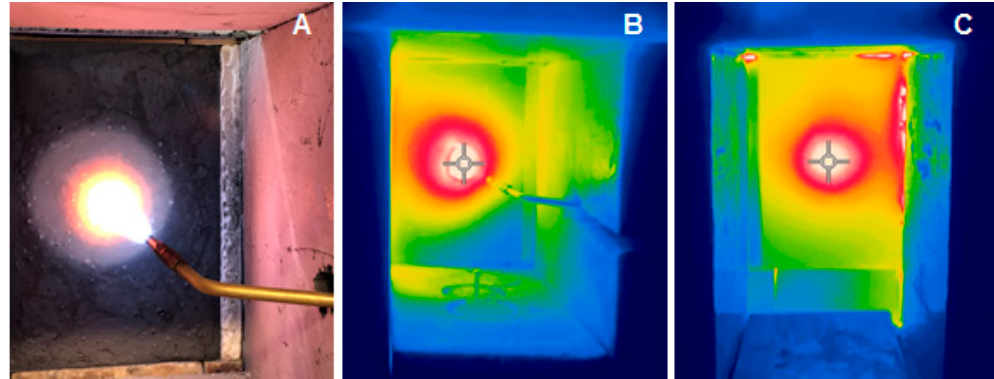
Figure 5. Mini fire-jet test example. ( A , B ) View from the side of the combusted gases; ( C ) view of the surface not thermally treated.